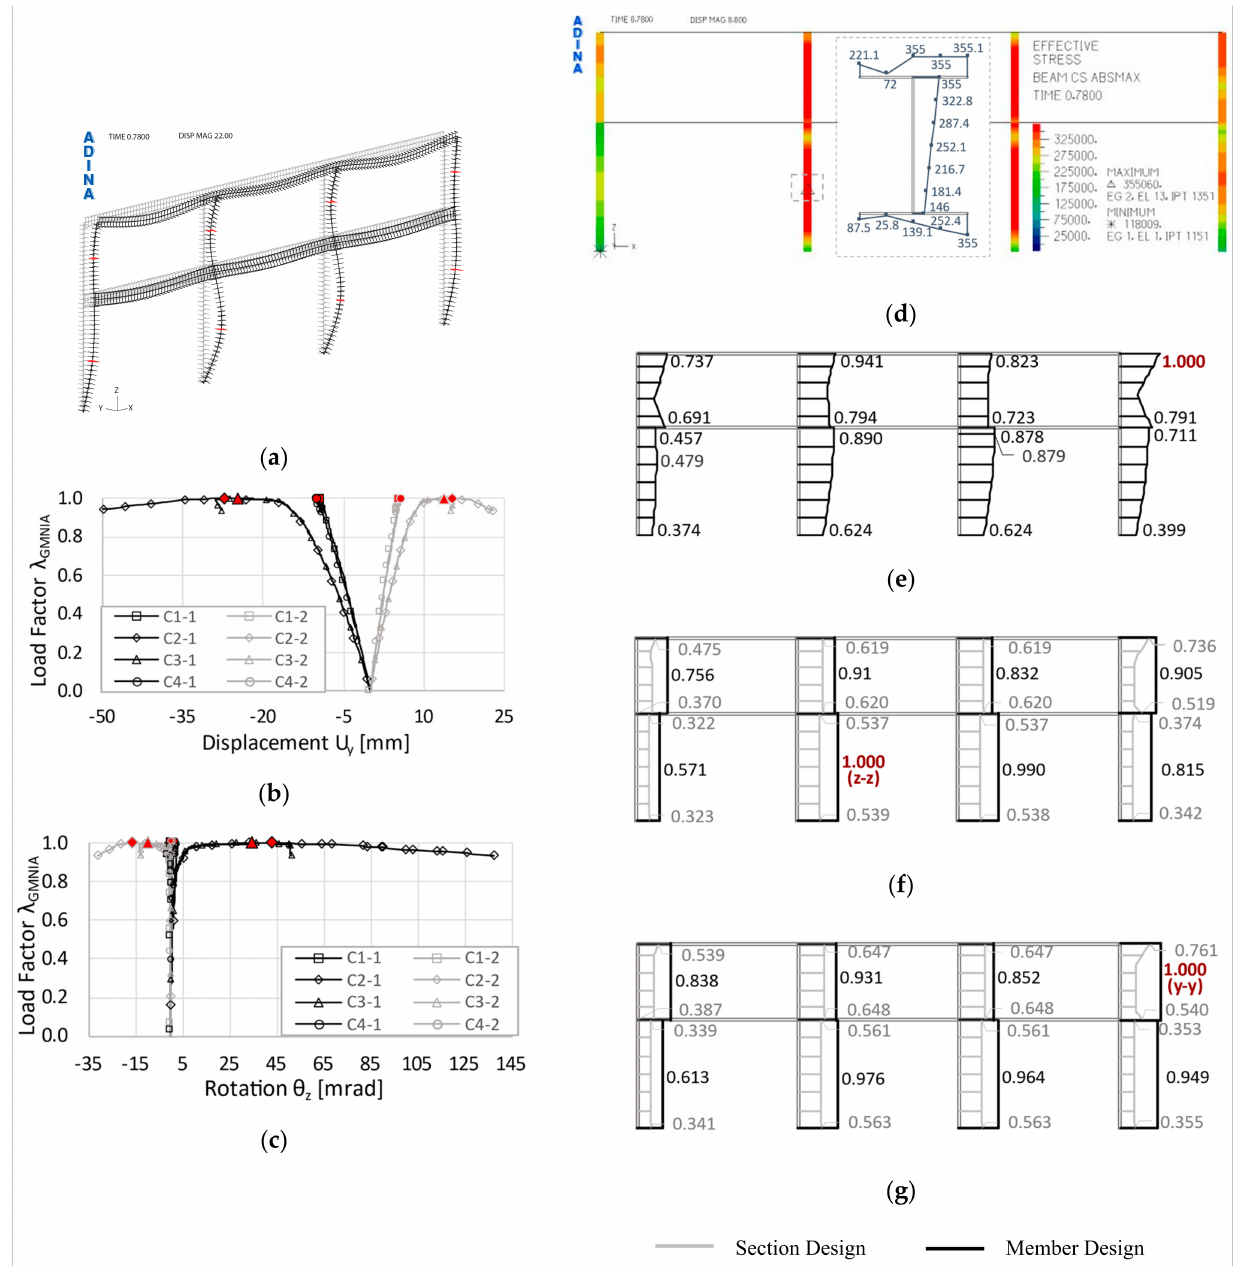
Figure 10. Collapse mechanism and utilization level of VHS frame—( a ) deformed shape (GMNIA); ( b , c ) equilibrium paths (GMNIA); ( d ) stress distribution (GMNIA); ( e ) utilization level (GNIA-SD); ( f ) utilization level (GNA-SMD); ( g ) utilization level